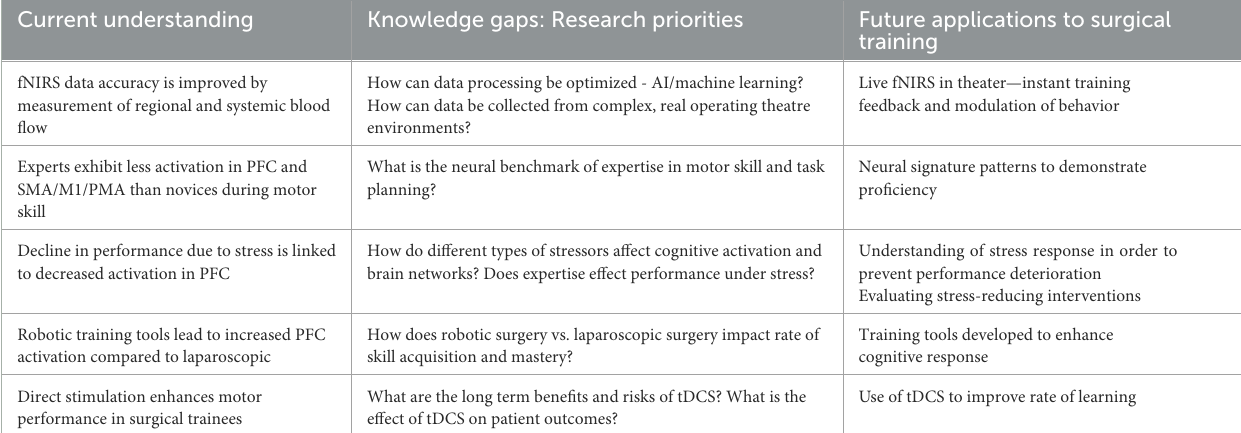
TABLE 1 Summary of current understanding, research gaps and future applications of neuromonitoring and neurostimulation to surgical training. Current